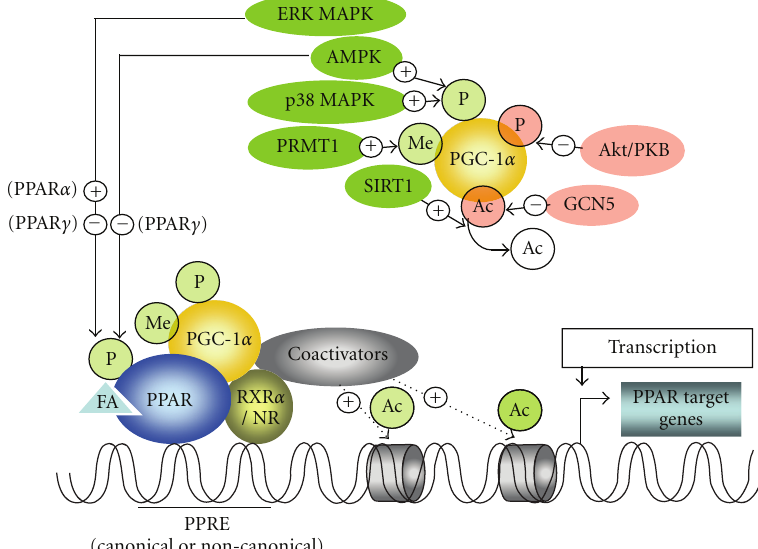
Figure 1: Modulation of the actions of PPAR through phosphorylation by ERK MAPK or AMPK or through regulation of PGC-1 α activity by various signaling events. Phosphorylation of the PPAR receptors can either increase or decrease their activity. SIRT1-mediated deacetylation activates PGC-1 α , while acetylation by GCN5 inhibits PGC-1 α -directed gene expression. Phosphorylation by AMPK or p38 MAPK increases the stabilization of PGC-1 α , whereas Akt/PKB-mediated phosphorylation facilitates its degradation. PRMT1 activates PGC-1 α through methylation at several arginine residues. Activation of PGC-1 α that is recruited to ligand-bound PPAR, the latter being complexed with RXR and/or other nuclear receptors, allows the recruitment of coactivators that acetylate the chromatin, allowing the DNA encoding a particular PPAR target gene to be transcribed. Ac, acetyl group; ERK MAPK, extracellular signal-regulated kinases/mitogen-activated protein kinase; AMPK, AMP-dependent protein kinase; Akt/PKB, Akt/protein kinase B; p38 MAPK, p38 mitogen-activated protein kinase; FA, fatty acid or metabolite from nutrients binding to and activating PPAR; Me, methyl group; P, phosphate group; PGC-1 α , peroxisome proliferator- activated receptor γ coactivator-1 α ; PPAR, peroxisome proliferator-activated receptor; PPRE, PPAR response element; PRMT1, protein arginine methyltransferase 1; RXR, retinoid X receptor; NR, nuclear receptor; SIRT1, sirtuin 2 ortholog 1; +, activation; − ,